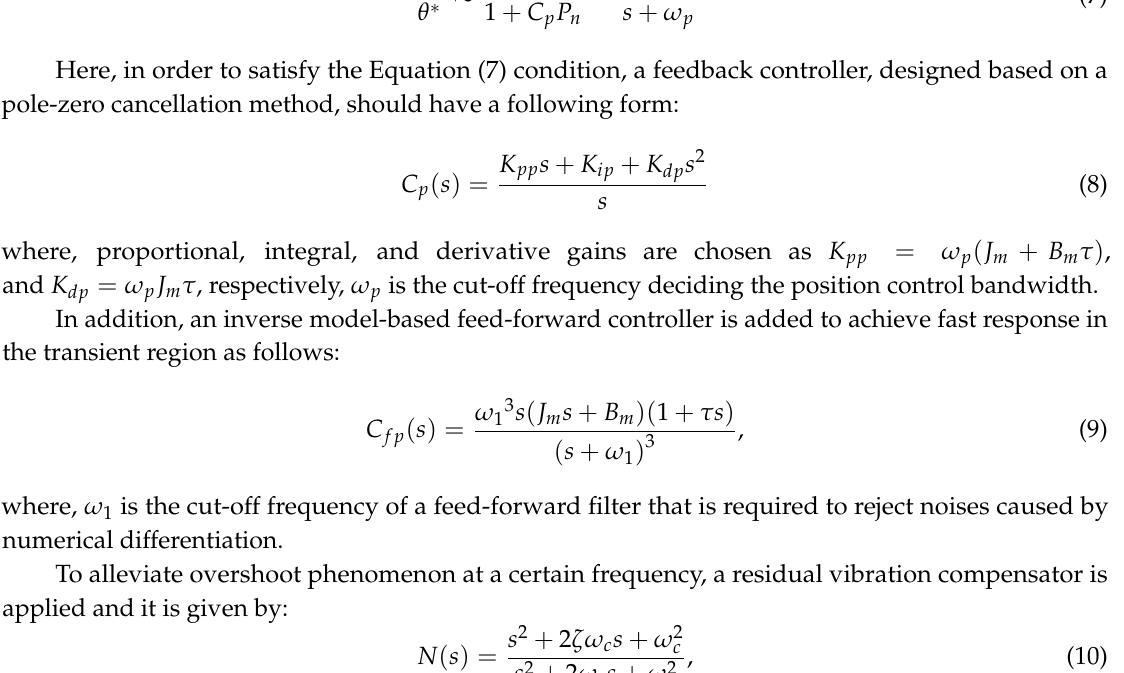
Figure 8. Structure of a two-degree-of-freedom position controller with a position-mode disturbance observer (P-DOB).